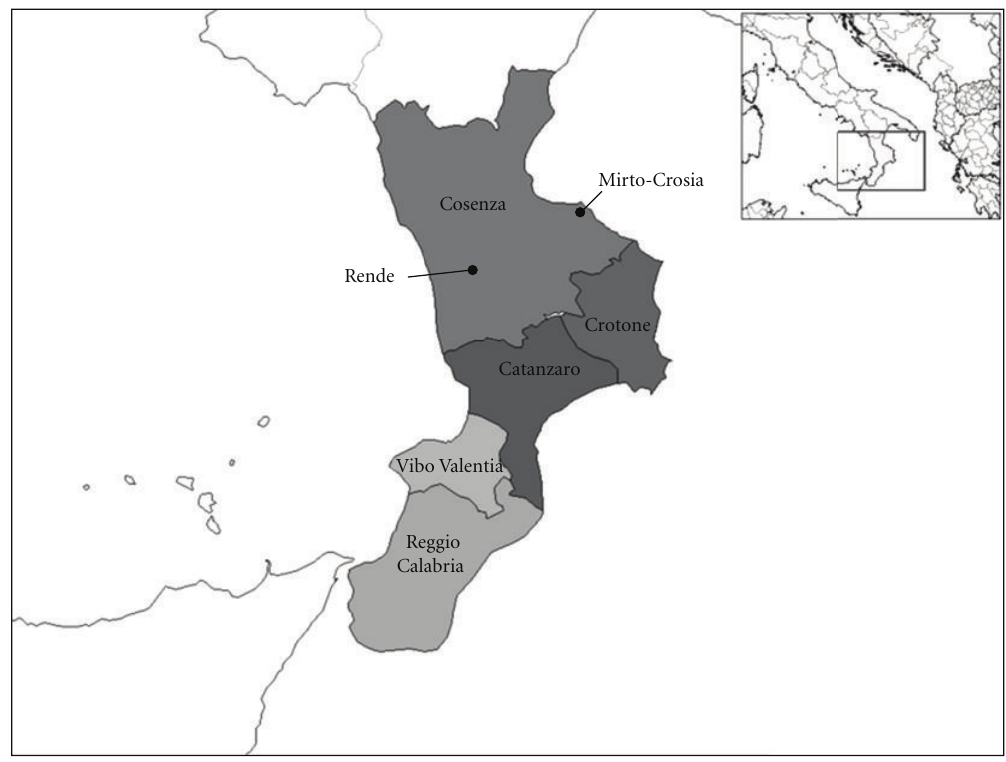
Figure 2: Map of areas where samples were collected. The samples come from two di ff erent growing places of the Calabria region